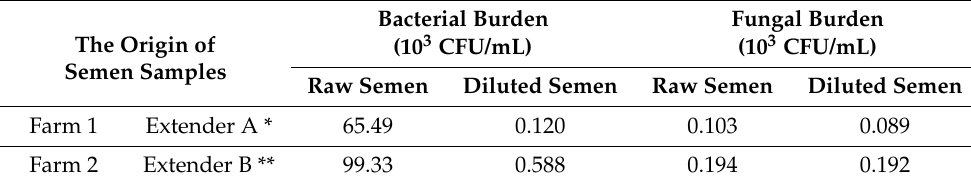
Fungal Burden (10 3 CFU/mL)